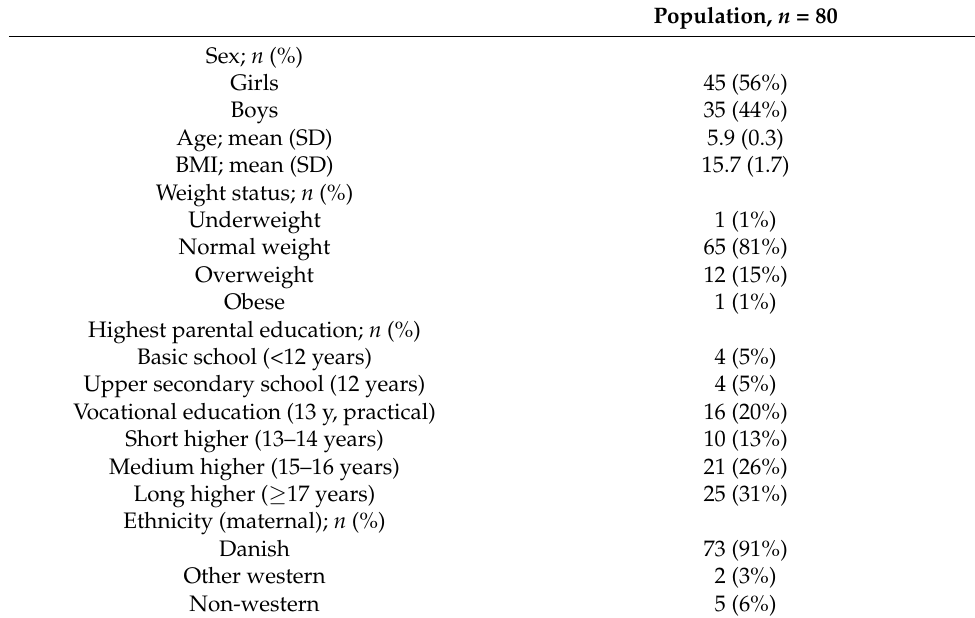
Table 1. Summary of the characteristic of the study